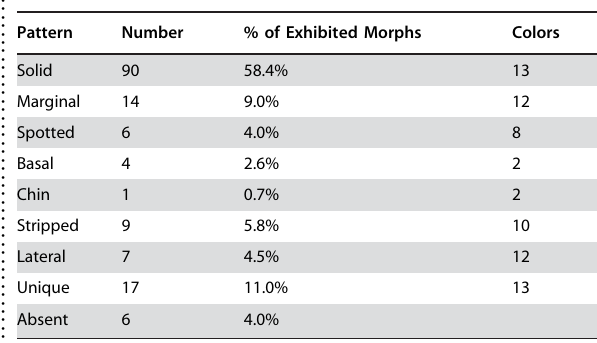
Table 2. Distribution of dewlap patterns exhibited